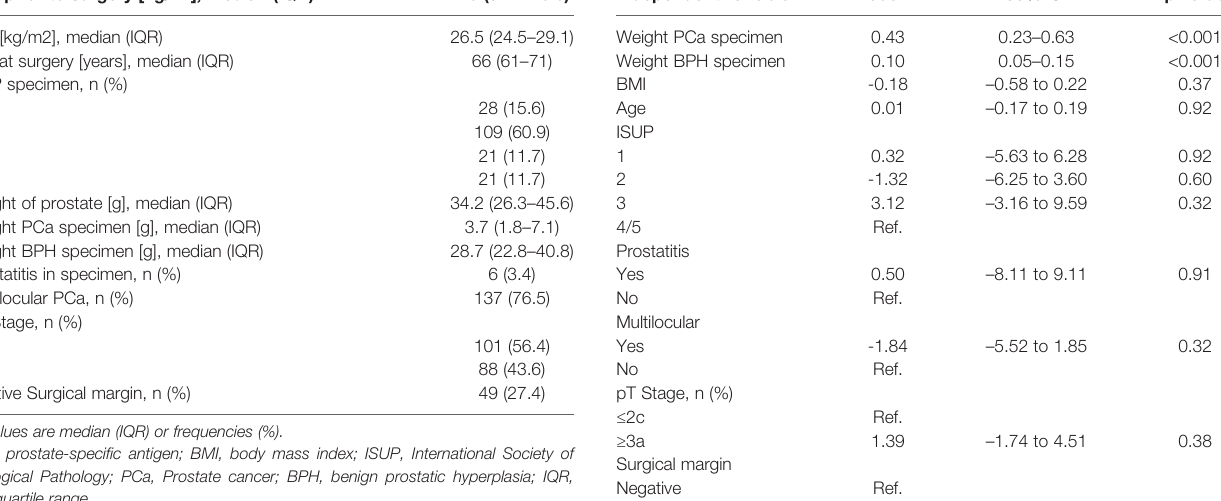
TABLE 1 | Descriptive characteristics of study population undergoing radical prostatectomy between January 2019 and June 2020 (n=179). PSA prior to surgery [ng/ml], median